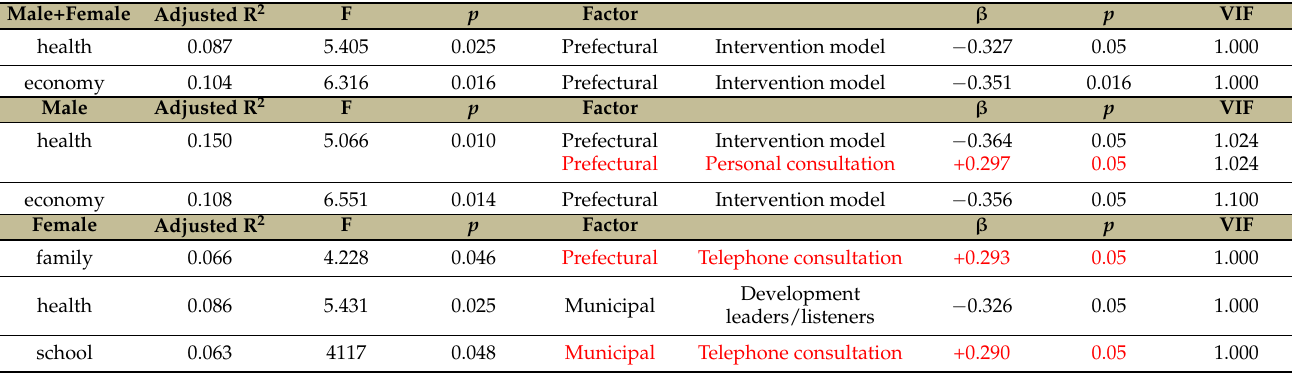
Table 2. Effects of the funding for the sub-divisions of the Emergency Fund to Enhance Community-Based Suicide Countermeasures (EFECBSC) on Male+Female, male and female EBSMR trends of suicide mortalities caused by family-, health-, economy- and school-related motives. The red colour sub-divisions of the EFECBSC indicate negative effects on the prevention of suicide mortality. VIF: variance inflation